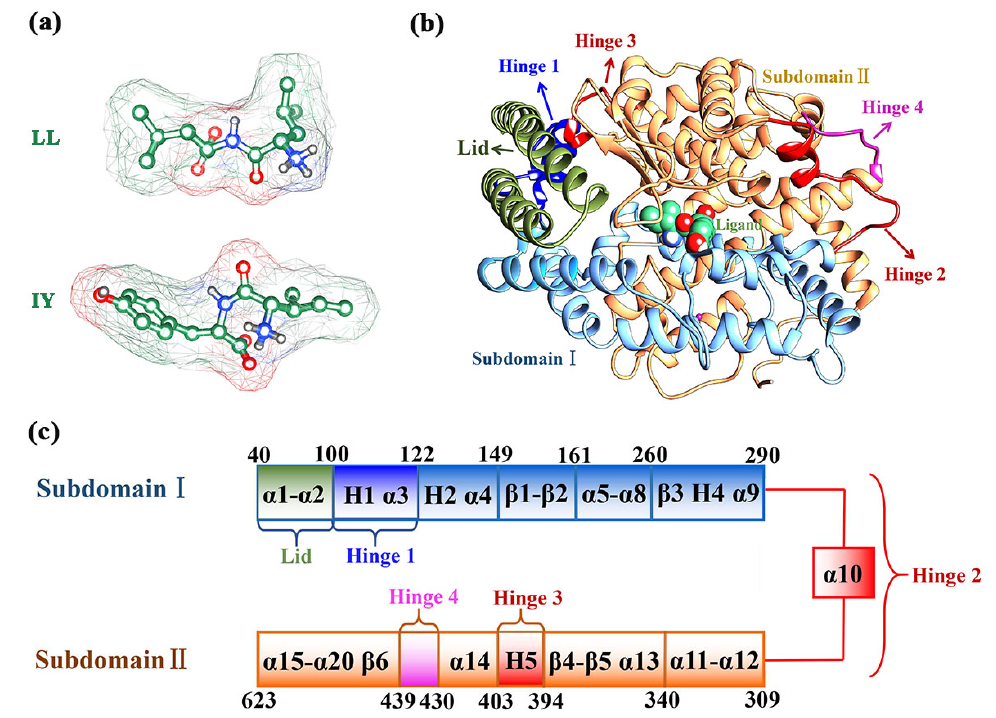
Figure 1. Stereo structures of the ligands and complex: ( a ) 3D structures of IY and LL. IY is the dipeptide Ile-Tyr, and LL is the dipeptide Leu-Leu; ( b ) complex of the ACE (angiotensin-converting enzyme) and inhibitory peptide; ( c ) detailed diagram of the secondary structure of ACE.